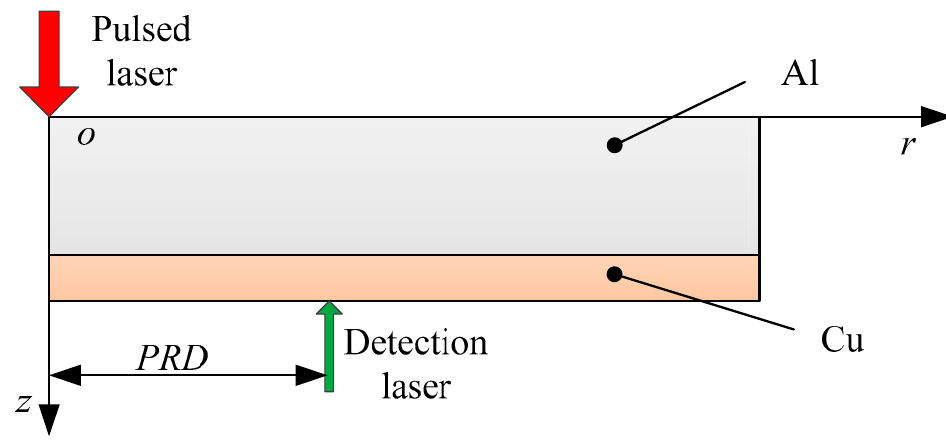
Figure 2. The schematic diagram of 2D axisymmetric fi nite element model.